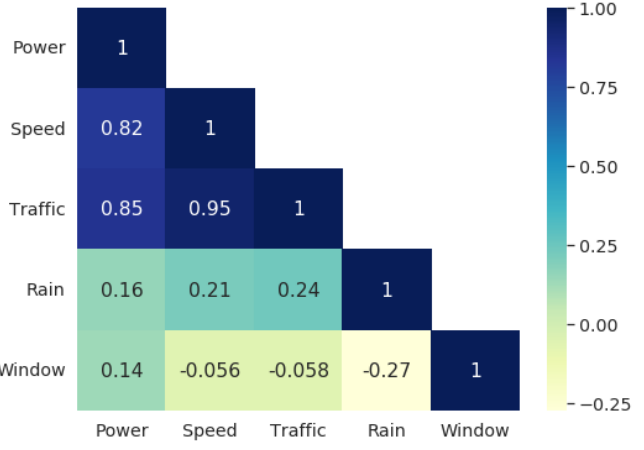
Figure 14. Correlation matrix of the